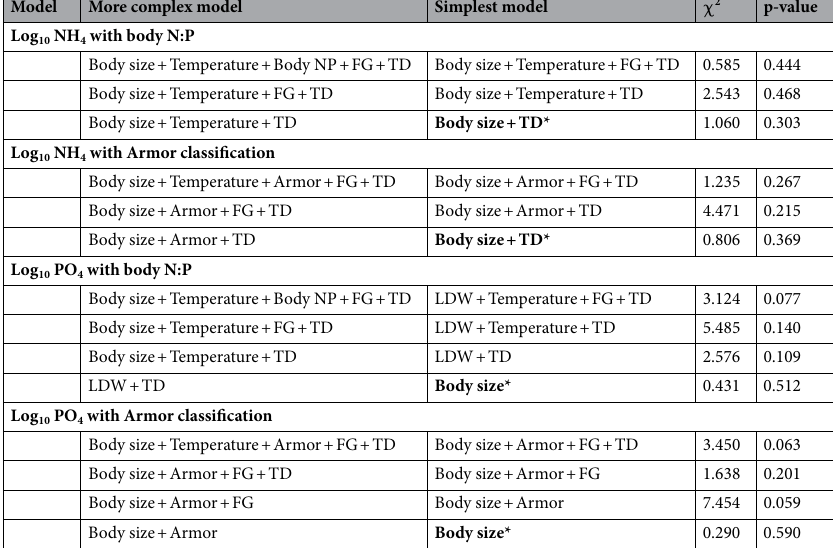
Table 2. Pairwise comparison of models fitted to N and P excretion rates for fish in a Brazilian stream. We used the testing-based procedures based on backward elimination and Chi-square test to select the final model. The variables Body NP, Armor and Feeding Group (FG) are the predictors for the Ecological Stoichiometry Theory, while Body size and Temperature are the predictors for the Metabolic Theory of Ecology. Time of day (TD) refers to the period of day (daytime or nighttime) in which the fish incubation took place. * Indicates the final selected